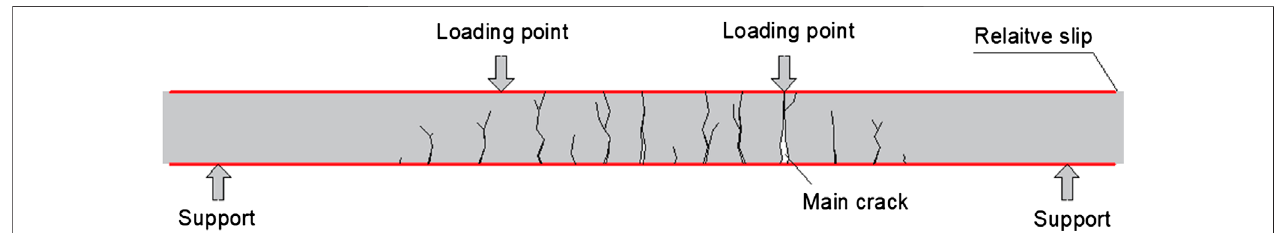
FIGURE 6 | Distribution of concrete